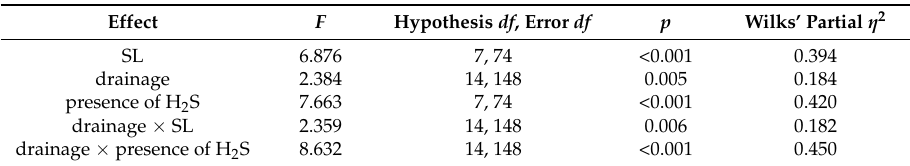
Table 2. Results from MANCOVA using principal components (PCs) based on L * a * b * values of 10 spots on the body of male Poecilia spp. as dependent variables. F -ratios and effect strengths (partial η 2 ) were approximated using Wilk’s λ . SL: standard